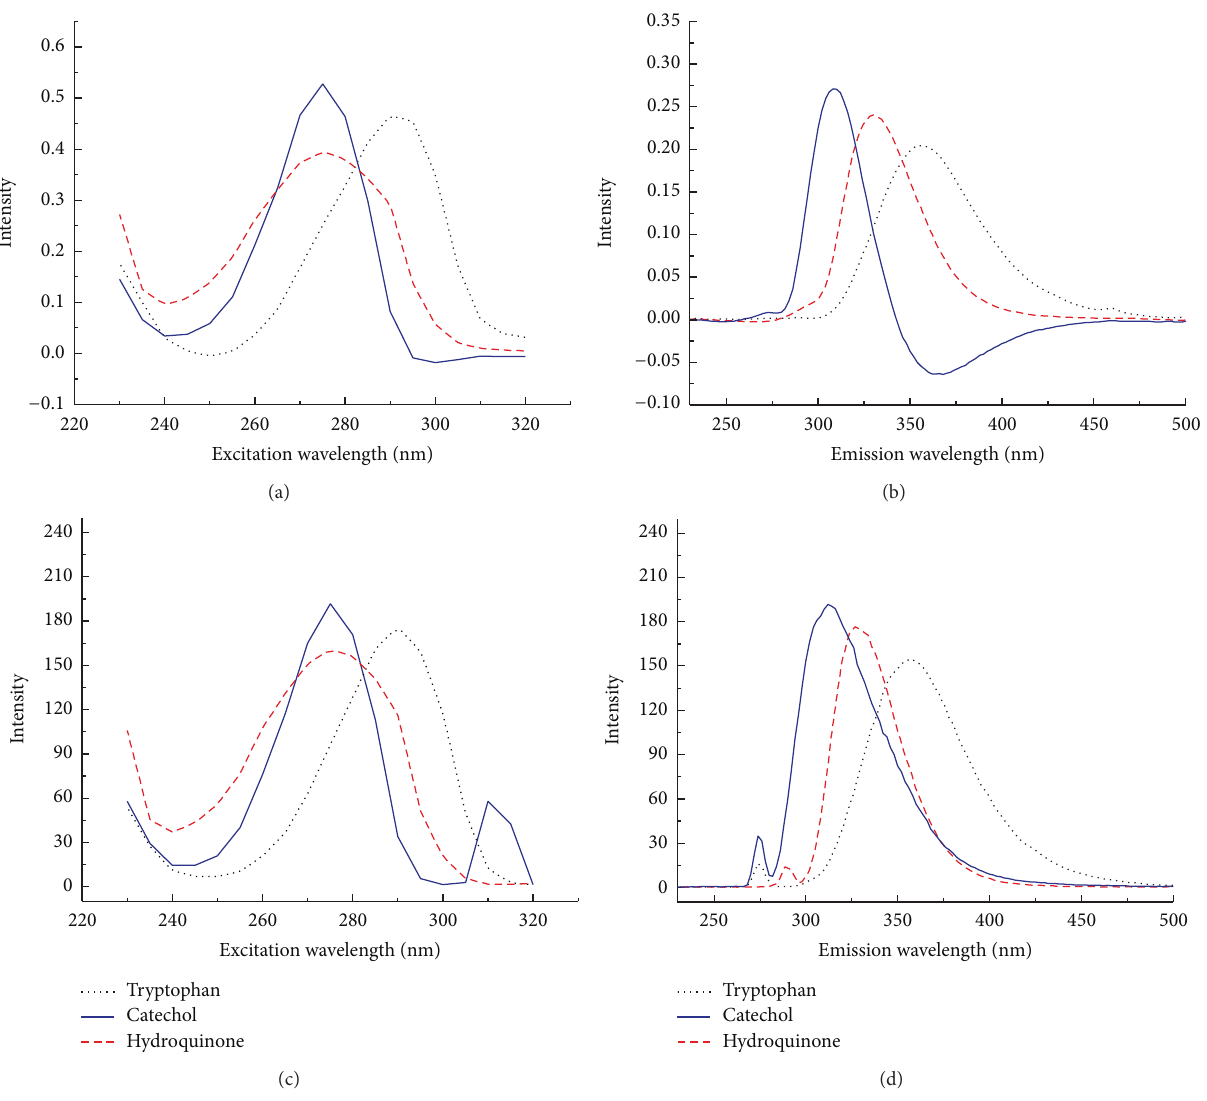
Figure 5: The profiles of the three factors from the decomposition of the data array by the PARAFAC with four factors and the corresponding pure spectra: (a) excitation spectra from PARAFAC, (b) emission spectra from PARAFAC, (c) pure excitation spectra, and (d) pure emission